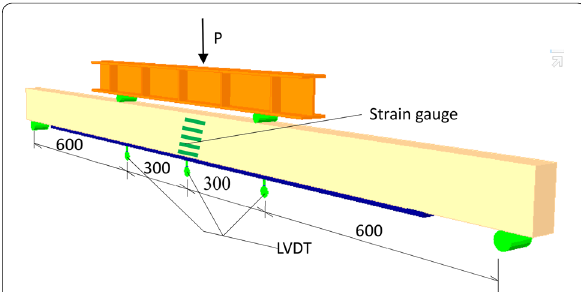
Fig. 5 Test arrangement (four-point bending) and instrumentation (unit: mm)